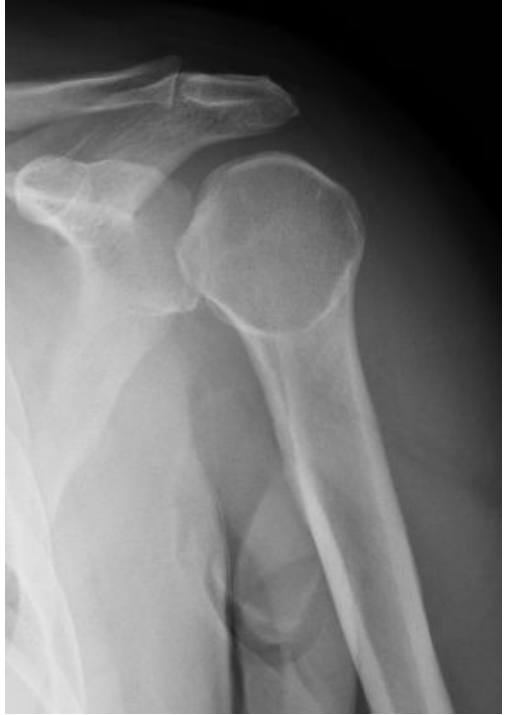
Figure 1. RX made in emergency: AP scan.